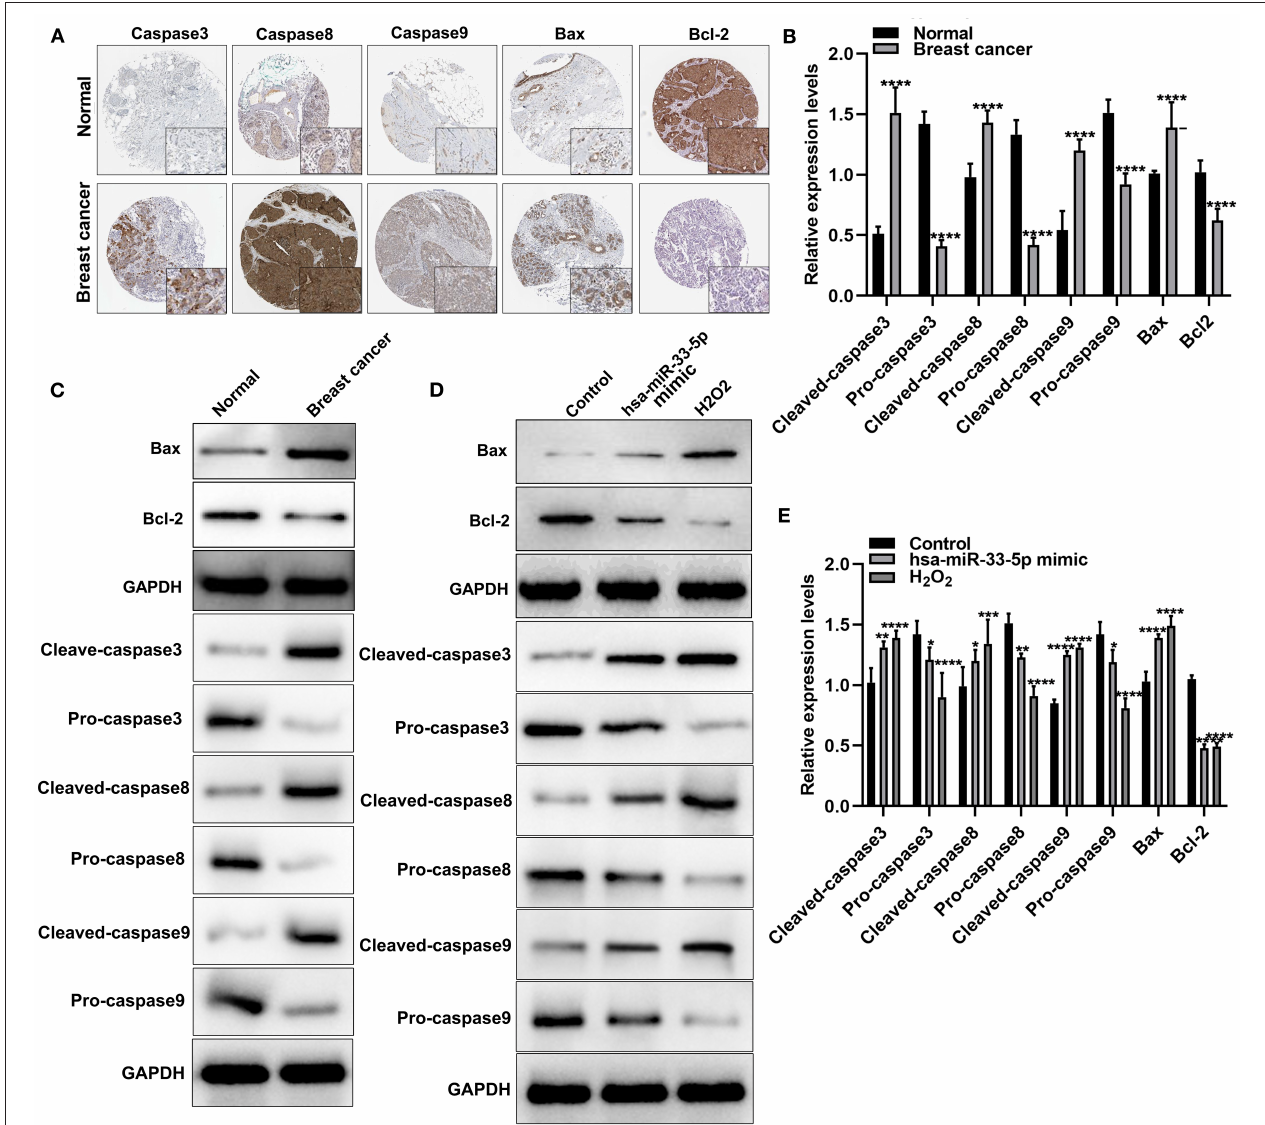
FIGURE 2 | hsa-miR-33-5p significantly mediates apoptosis-related proteins in breast carcinoma cells. (A) Immunohistochemistry for the expression and distribution of the apoptosis-related proteins including caspase-3/8/9, Bax, and Bcl-2 in breast cancer tissues and normal tissues. (B,C) Western blot for the expression of apoptosis-related proteins including cleaved caspase-3, pro-caspase-3, cleaved caspase-8, pro-caspase-8, cleaved caspase-9, pro-caspase-9, Bax, and Bcl-2 in breast cancer tissues and normal tissues. (D,E) Western blot for the expression of cleaved caspase-3, pro-caspase-3, cleaved caspase-8, pro-caspase-8, cleaved caspase-9, pro-caspase-9, Bax, and Bcl-2 in breast cancer cells transfected with hsa-miR-33-5p mimics. * p < 0.05; ** p < 0.01; *** p < 0.001; **** p < 0.0001.